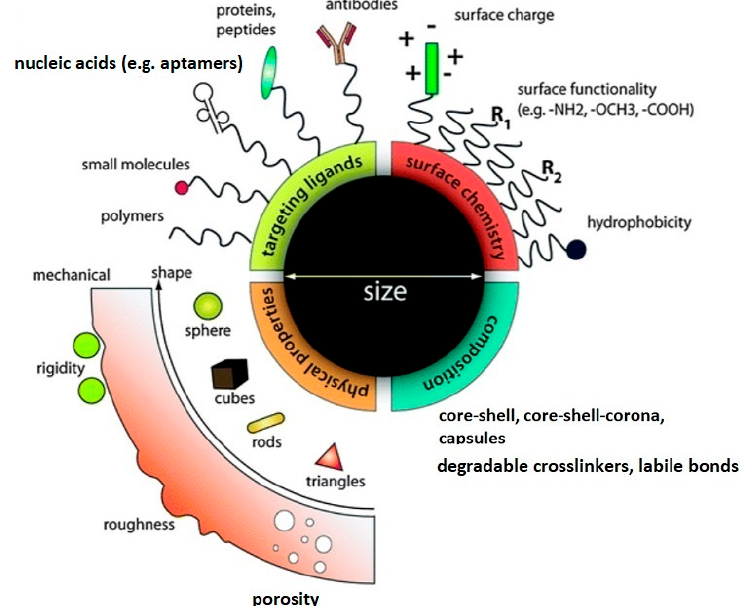
Figure 2. Design aspects of degradable biomolecule/nanogel hybrids for targeted delivery. Various types of biomolecules, e.g., proteins, nucleic acids, and antibodies, can be accumulated / grafted in NGs with specific routes of surface activation and moderation. Reprinted from Reference [30] with permission from the Royal Society of Chemistry.